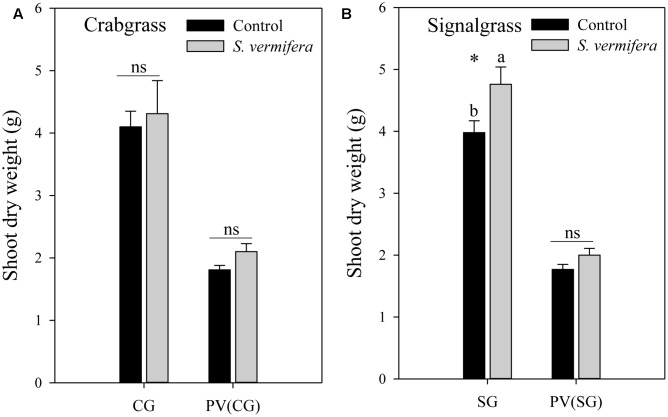
Effect of non-targeted colonization of S. vermifera on biomass of (A) Crabgrass and (B) Signalgrass planted around central colonized or un-colonized control switchgrass in the endocosm assembly (Figure 2c) 8 weeks after colonization. Error bars denote standard error of mean. ns: p > 0.05. CG: Crabgrass; SG: Signalgrass; PV(CG) and PV(SG): Switchgrass (Panicum virgatum) in the center surrounded by Crabgrass (CG) and Signalgrass (SG) respectively.